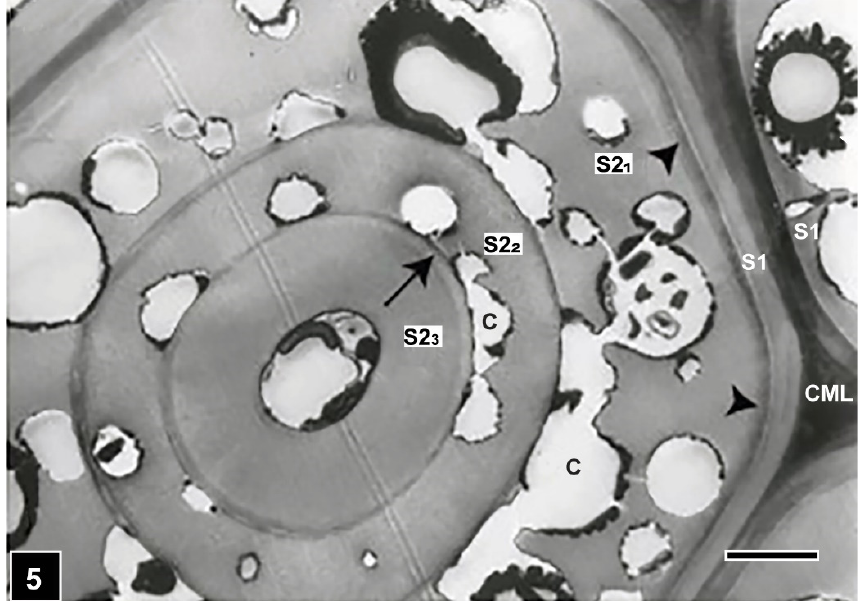
Figure 5. TEM of a transverse section through a Koompassia malaccensis fibre wall attacked by soft rot. The S2 wall is multilamellar, consisting of thick lamellae (S2-1, S2-2, S2-3) alternating with extremely thin lamellae (arrow). The face of soft-rot cavities (C) along the more highly lignified thin lamellae has a flattened appearance. The arrowheads point to a highly lignified region of the S2-1 lamella, underlying S1. CML, compound middle lamella. Scale bar = 2 µm. The image is reproduced from Singh et al. (2018) IAWA J.